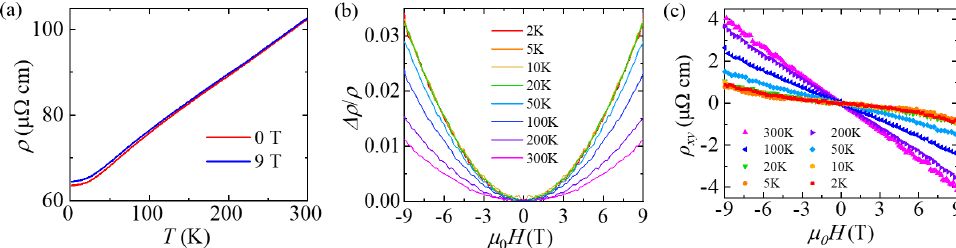
Figure 2. ( a ) Temperature dependent resistivity for LaSbSe, measured with and without applying a magnetic field of 9 T. ( b ) Normalized magnetoresistance at various temperatures for LaSbSe. ( c ) magnetic field dependent Hall resistivity at various temperatures for LaSbSe.